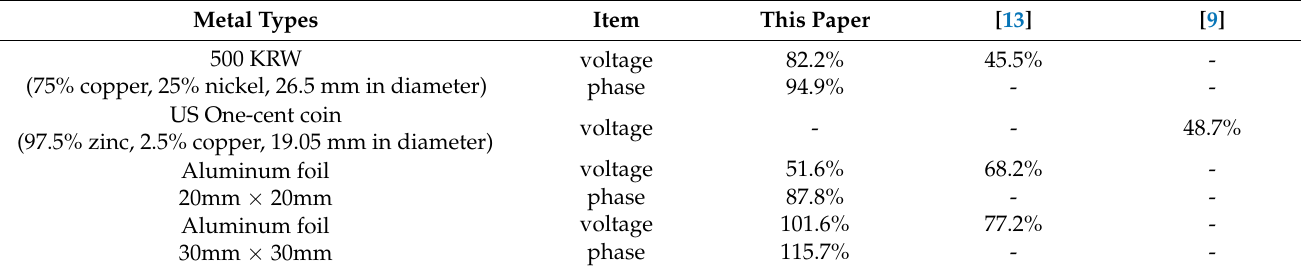
Table 3. Comparison of voltage and phase variation with previous papers.